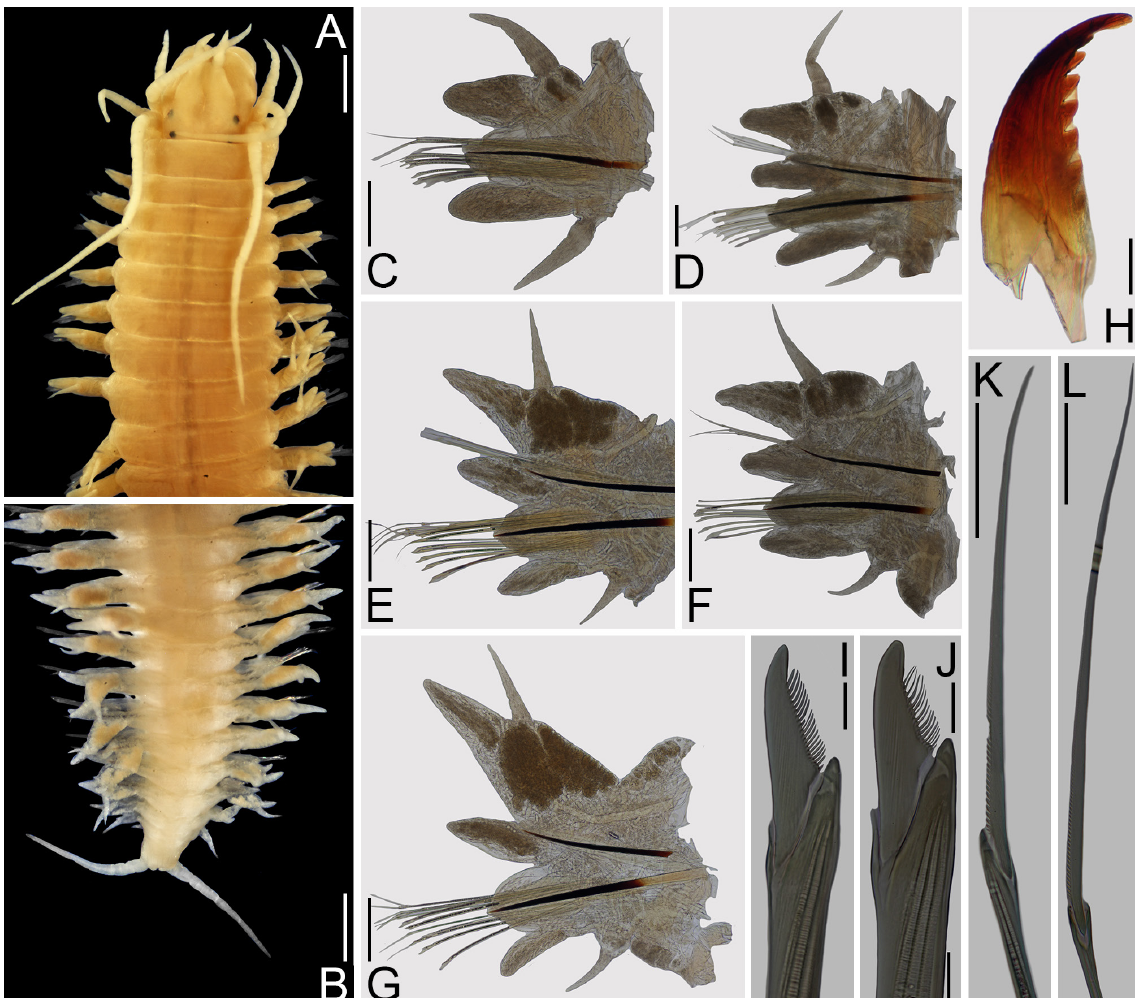
Fig. 11. Perinereis floridana (Ehlers, 1868). Non-types (ECOSUR P1100). A . Anterior end, dorsal view. B . Posterior end, dorsal view. C . Chaetiger 2, right parapodium. D . Chaetiger 10, right parapodium. E . Chaetiger 28, right parapodium. F . Chaetiger 61, right parapodium. G . Chaetiger 91, right parapodium. H . Left jaw, dorsal view. I . Supra-acicular heterogomph falciger, chaetiger 61. J . Sub- acicular heterogomph falciger, chaetiger 61. K . Sub-acicular heterogomph spiniger, chaetiger 61. L . Supra-acicular homogomph spiniger, chaetiger 61. Scale bars: A–B = 1 mm; C–H = 0.25 mm; I–J = 10 μm; K–L = 50